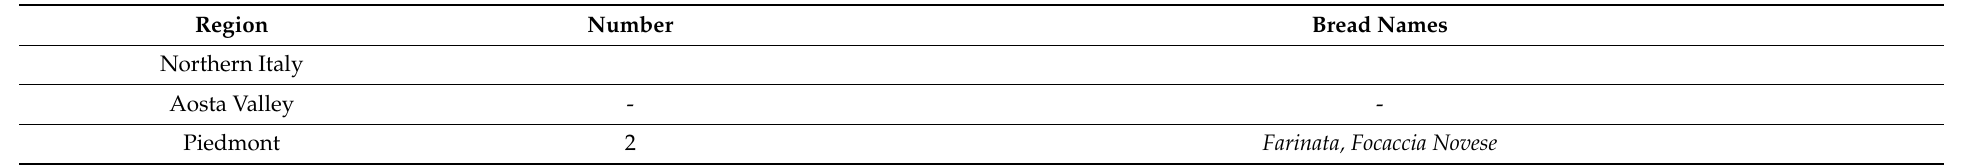
Table 12. Italian flat breads awarded by the Italian quality mark “ Prodotti Agroalimentari Tradizionali ” (PAT, meaning “Agri-food Traditional Products”), geographically subdivided based on their origin in northern, central, southern Italy or its